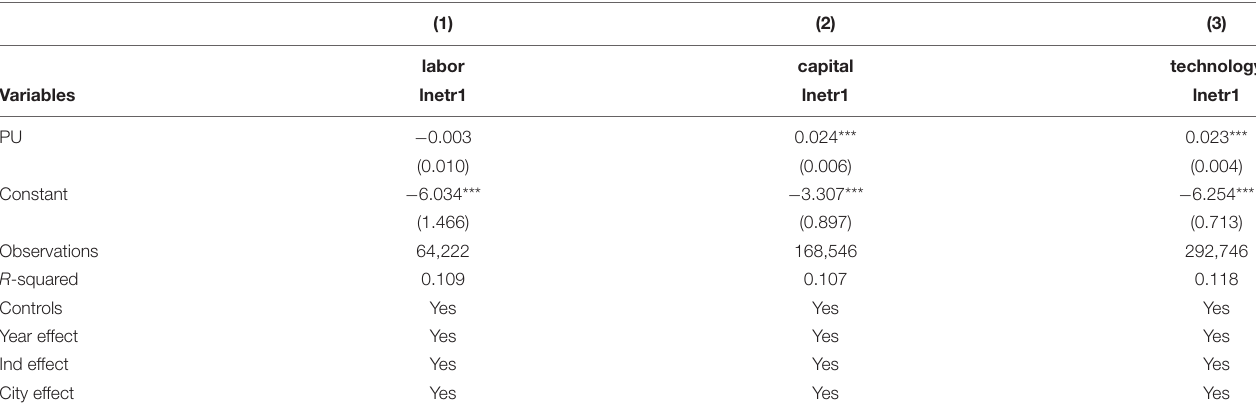
TABLE A2 | Regression analysis of firms grouped by factor